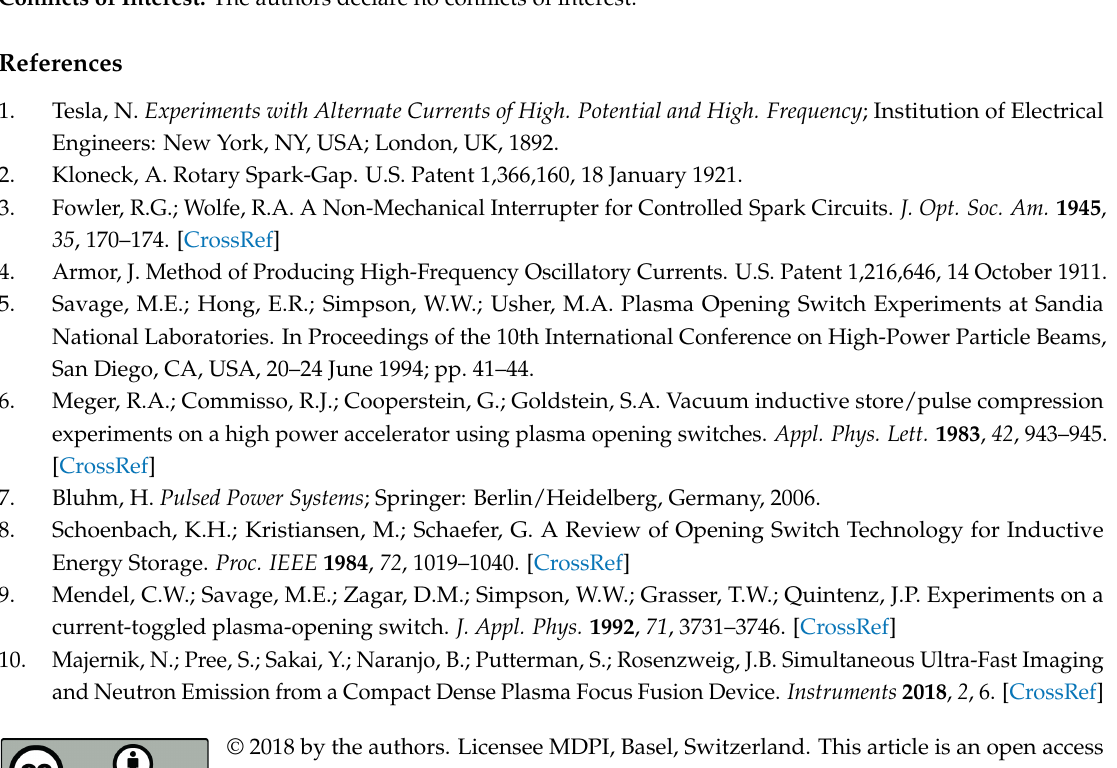
Figure 9. A proposed future version of the switch with pulsed electromagnets to allow for optical